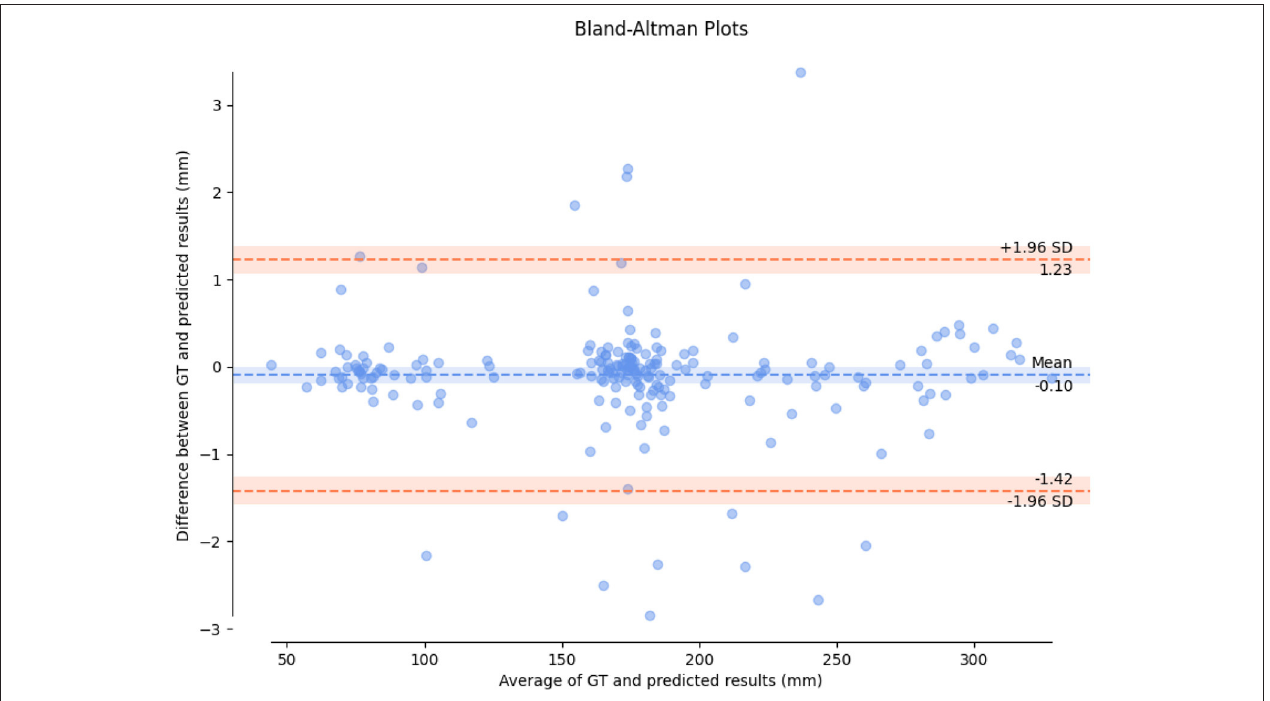
FIGURE 8 | A Bland-Altman diagram on validation